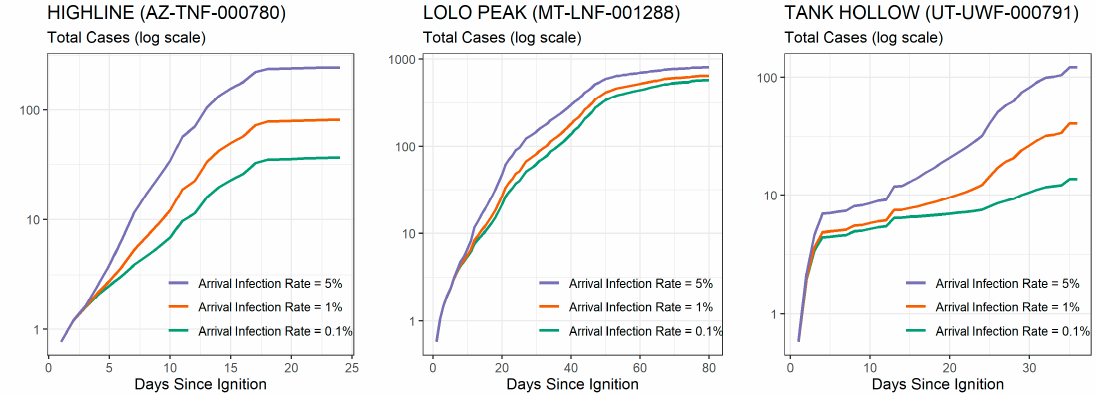
Figure 4. Total number of infected individuals over the duration of each incident under the low (0.1%), medium (1%), and high (5%) entry rates of infected individuals. Note that the vertical axis is log scaled. All simulations assume R0 of 2.68.